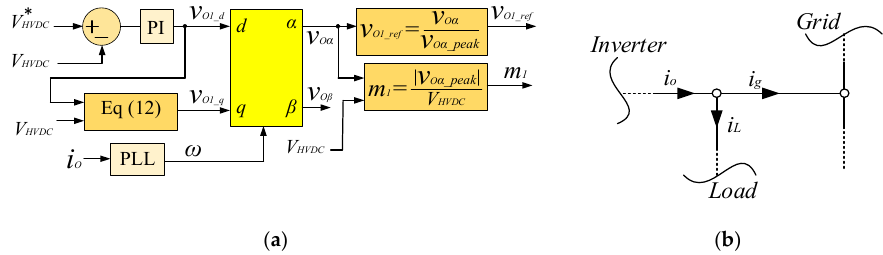
Figure 6. ( a ) The control system for the grid-connected inverter and ( b ) current direction reference in the inverter output.